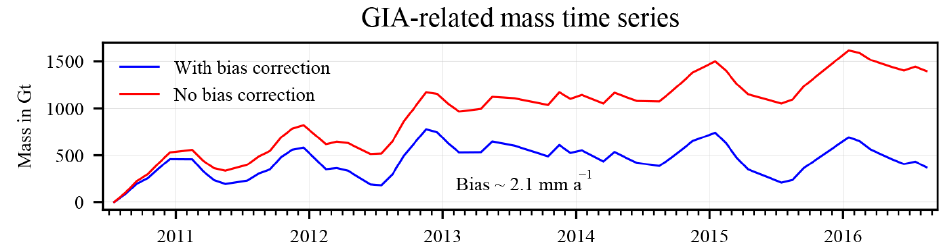
Figure 7. The GIA-related mass time series of the AIS (with 400km buffer zone) resulting from the combination of the monthly gridded time series (July 2010–August 2016) with (blue) and without (red) LPZ-based bias correction of the determined GIA